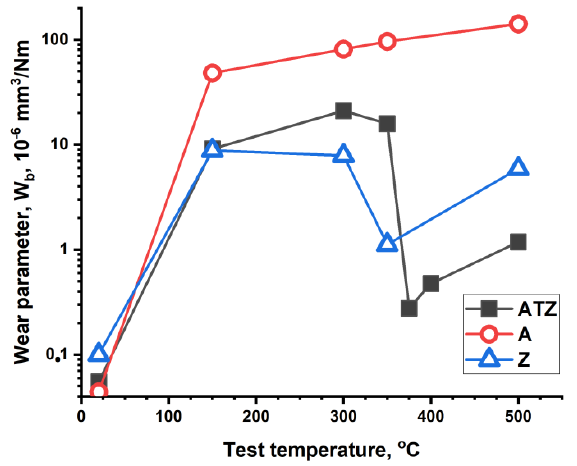
Figure 7. Plots of the wear parameter W s values measured for the investigated materials at different temperatures of the test. The symbols present the mean value of the three single measurements.